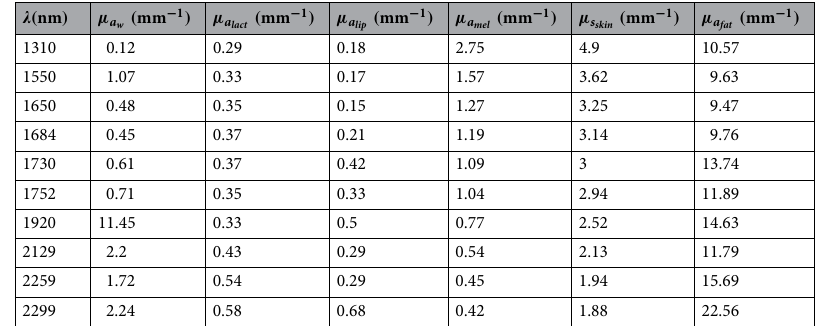
Table 1. Optical properties at SWIR: the absorption coefficients of water ( µ a melanin ( µ a ); and the scattering coefficients of skin ( µ s mel characterising wavelengths ( (cid:31)